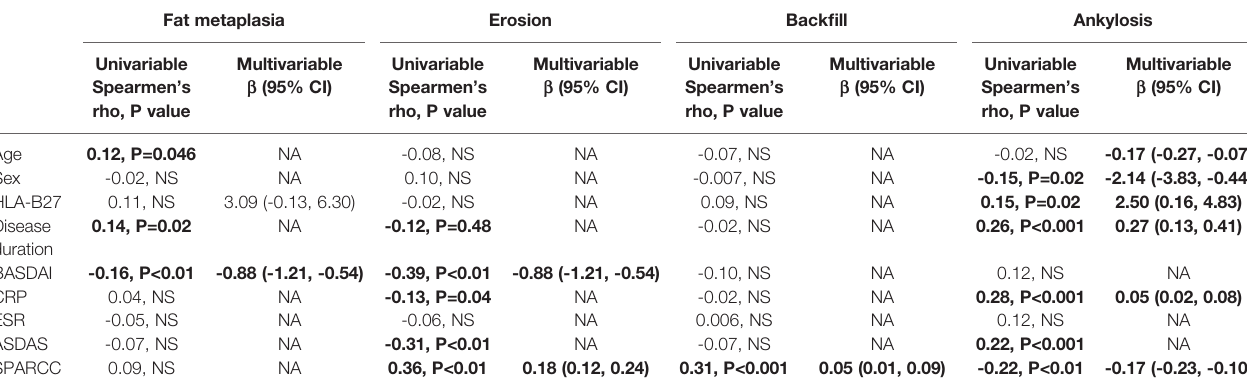
TABLE 3 | Factors associated with structural damages on MRI.